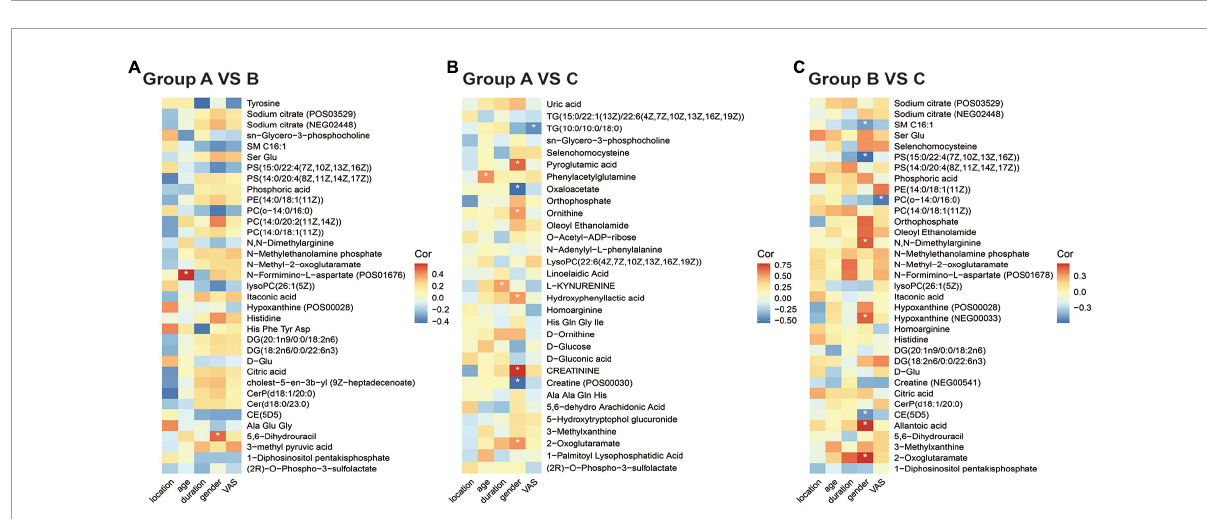
FIGURE3 Correlation heatmap between metabolic patterns and clinical data. (A–C) The heatmap of altered metabolic patterns between groups and clinical data: (A) Groups A vs. B, (B) groups A vs. C, (C) groups B vs. C. Clinical data including VAS, age, sex, location, and